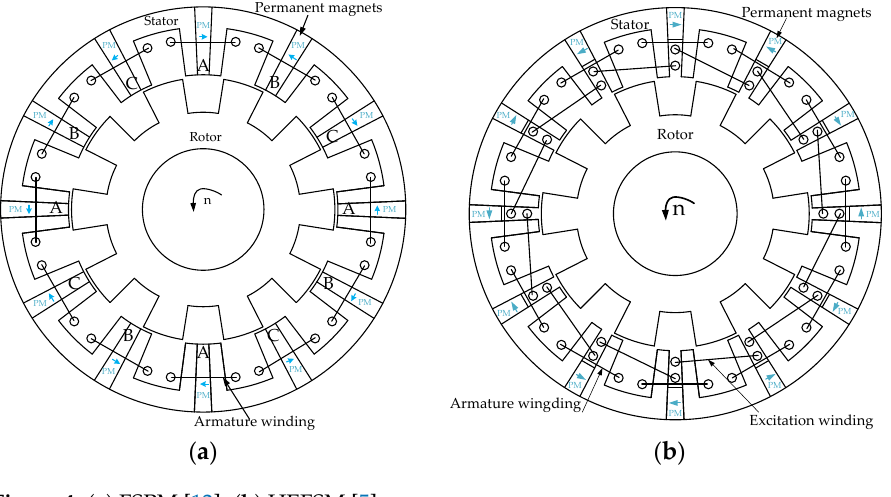
Figure 4. ( a ) FSPM [12]. ( b ) HEFSM [5].